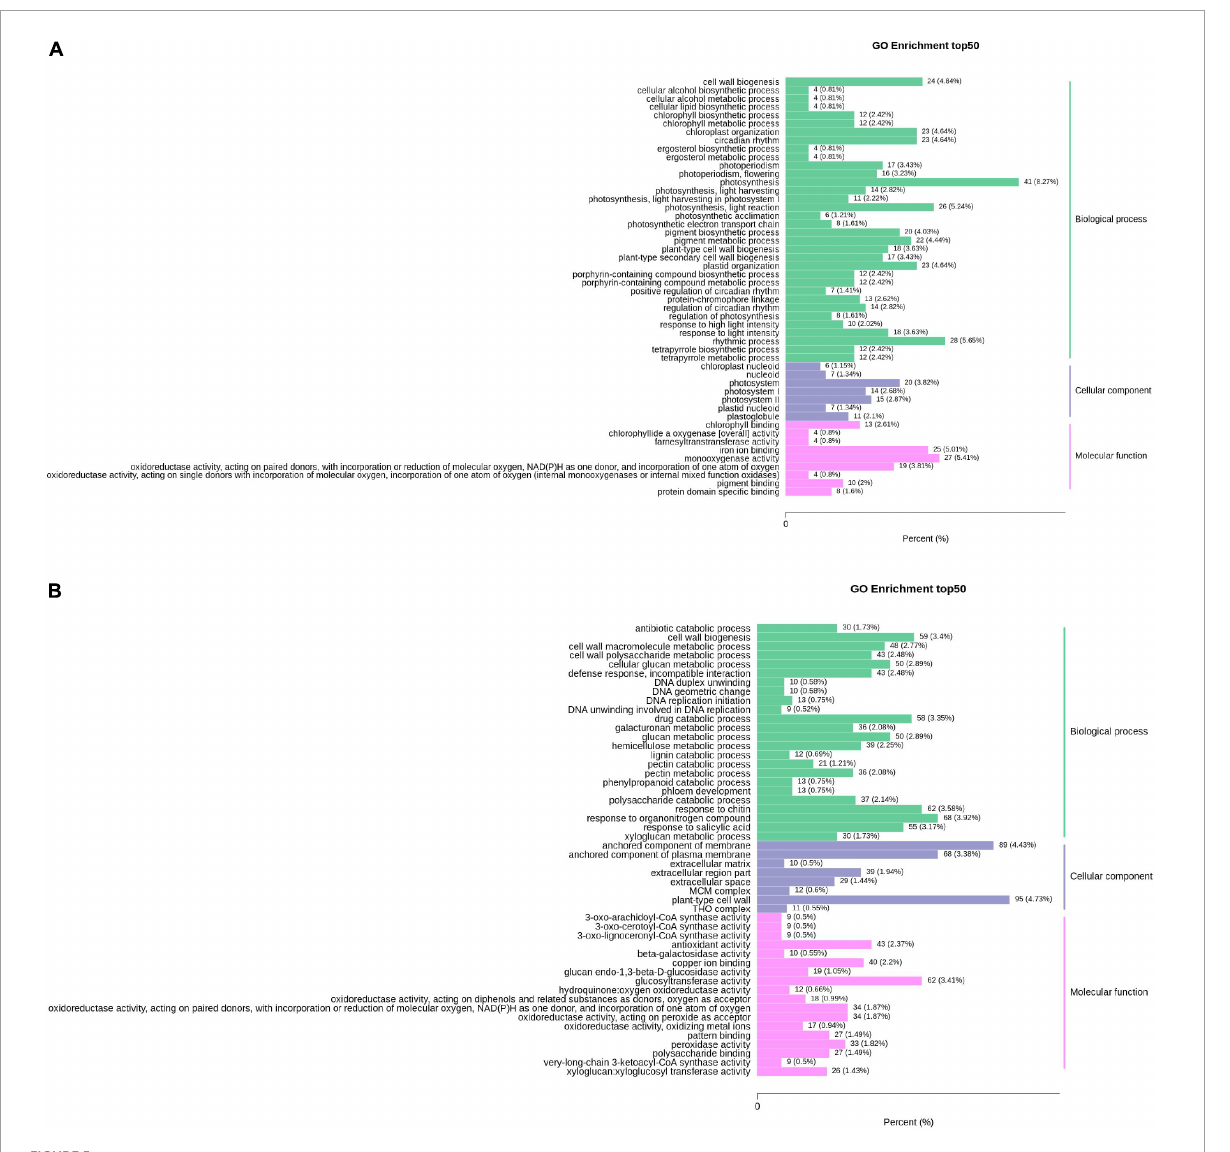
FIGURE5 Column chart of GO enrichment of DEGs. The abscissa represents the ratio of genes annotated to the entry to the total number of annotated genes, and the ordinate represents the name of the GO entry. The labels to the right of the graph represent the categories to which the GO entry belongs. (A) HN44 group; (B) HN65 group.